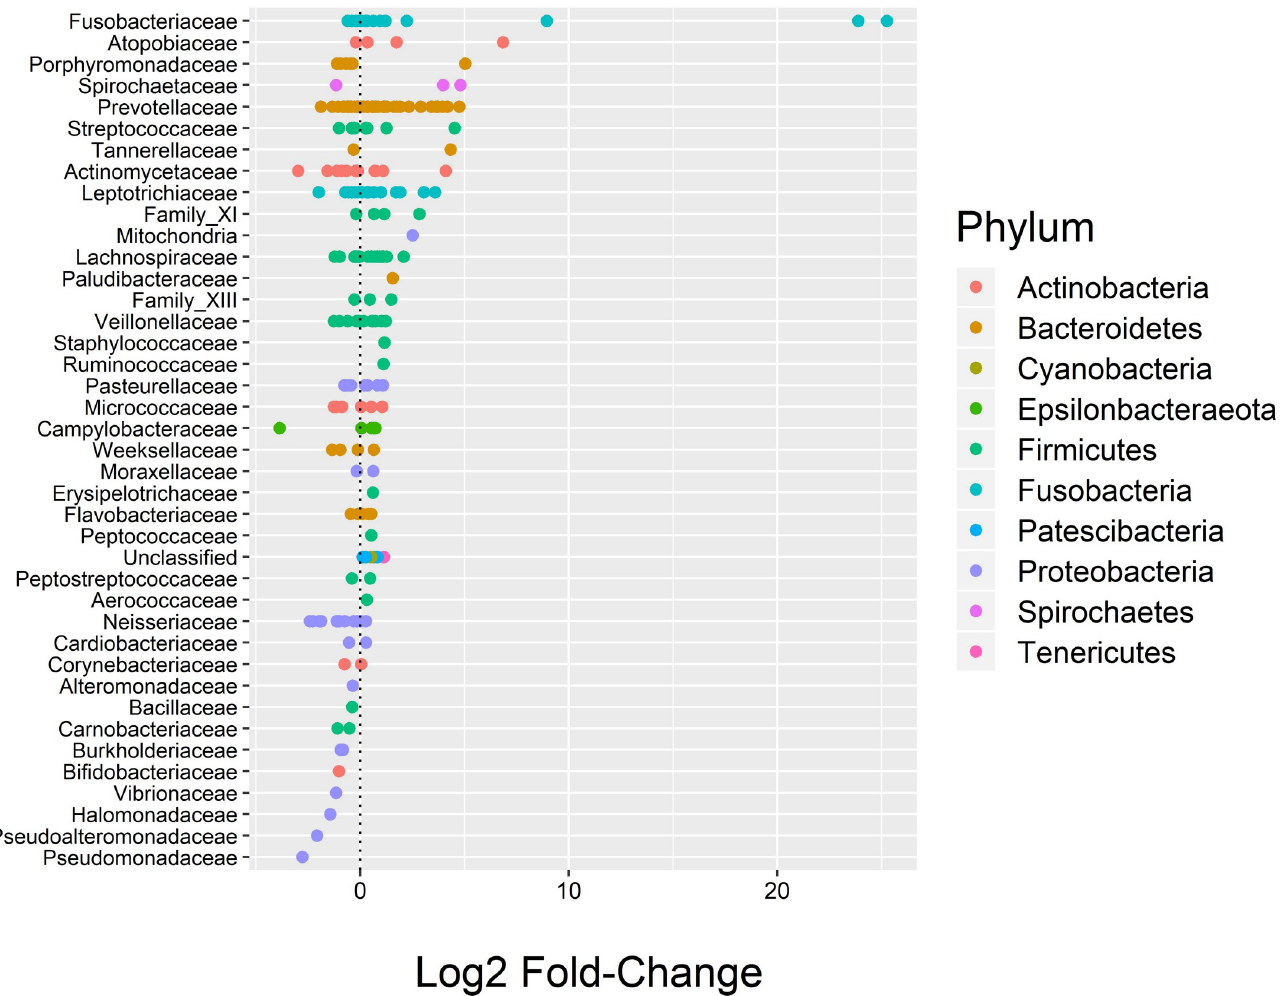
Fig 6. DESeq2 results showing the log2 fold-change values (x-axis) of bacteria in sputum between TRAP exposure groups. Each line on the y-axis indicates the family, each point represents an individual ASV within that family, and the color of the point indicates the phylum.